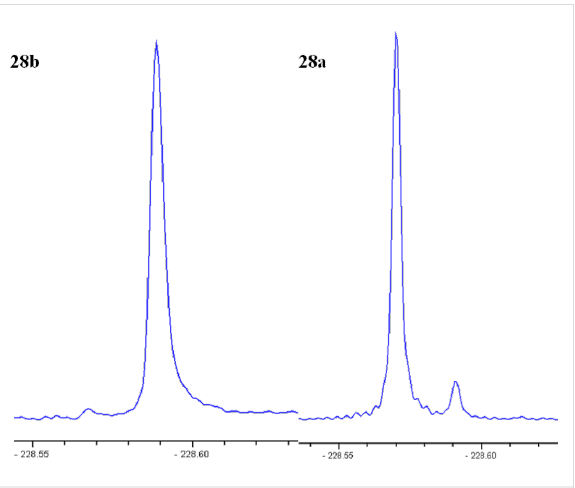
Figure 5: Partial 19 F{ 1 H} NMR (400 MHz, L-(+)-DIPT/CDCl 3 , 300 K) spectra of 28b and 28a using optimised conditions: SW 40; AQ = 0.8; O1P − 230; d1 = 5; 32 or 64